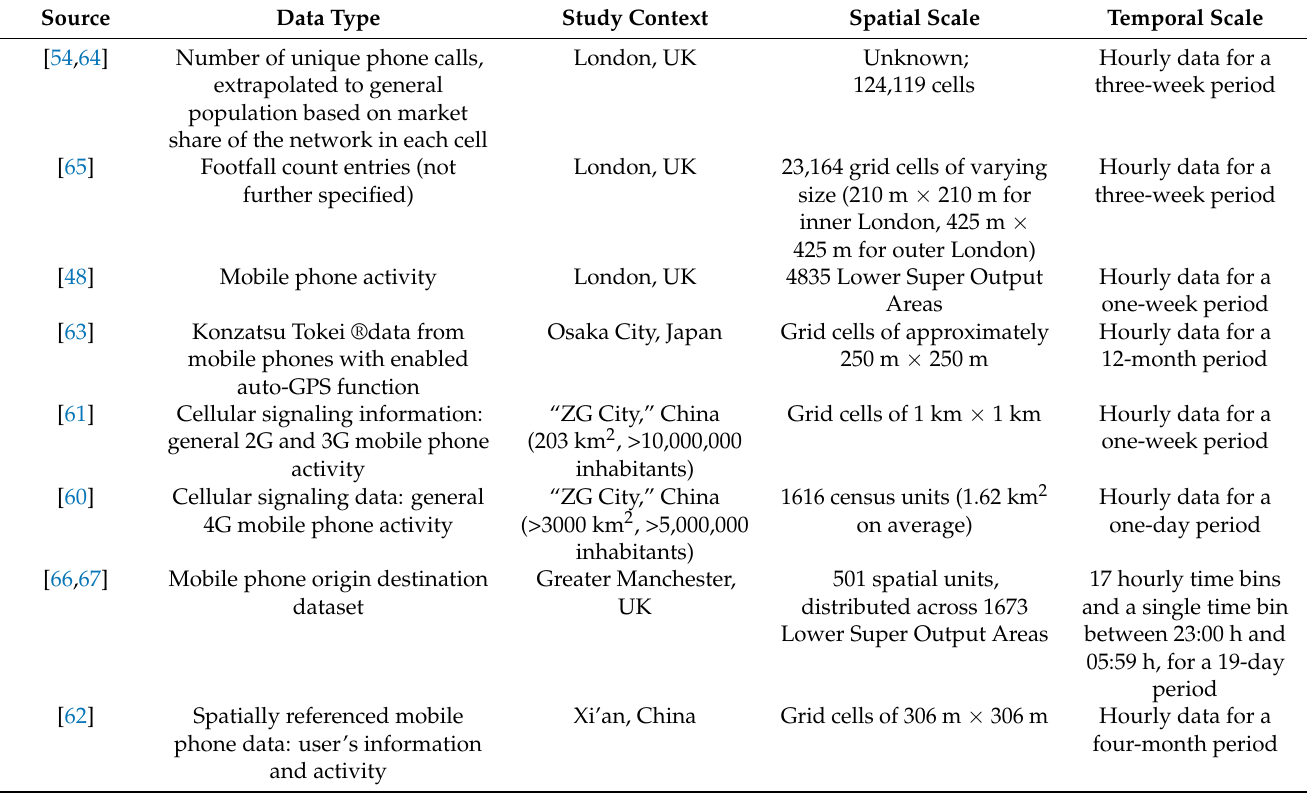
Table 1. General characteristics of prior research on spatiotemporal patterning of crime with mobile phone